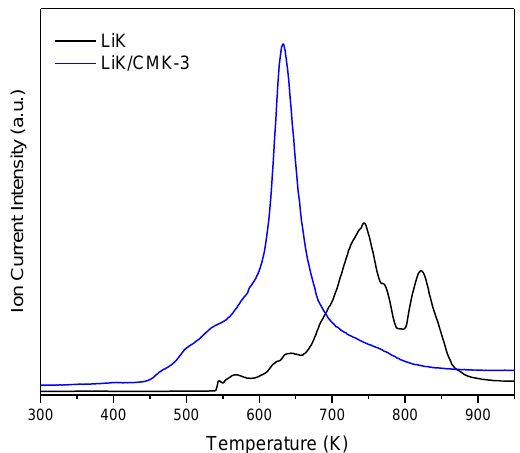
Figure 3. Temperature programmed desorption with mass spectrometry (TPD / MS) results for bulk LiK mixture (black) and LiK / CMK-3 composite (blue).